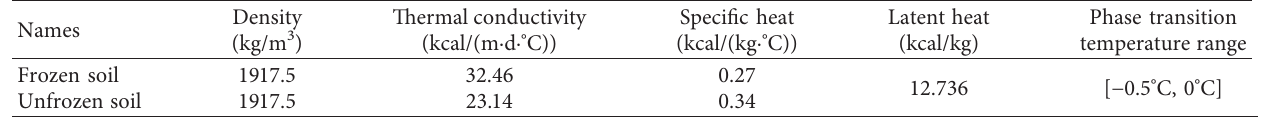
Figure 4: Mesh of computational models. (a) Model 6-1 and (b) model 12-3. Table 2: Thermophysical parameters.